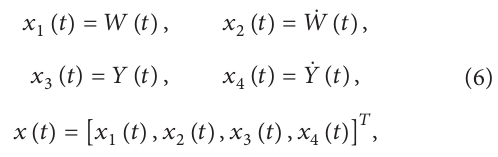
in which 𝑊(𝑡) is cable displacement from the equilibrium position; 𝑌(𝑡) is the displacement of the cable end, namely, the deck displacement along the axial direction of the cable; 𝜔 𝑢(𝑡) is control input variable; 𝜔 1 and 2 are the intrinsic frequencies of the cable and deck, respectively; 𝜉 is the damping ratio of the deck; 𝑎 𝑖 (𝑖 = 1, 2, . . . , 6) are parameters determined by the factors such as the mass per unit length and the dip angle of the cable and the regular function of the deck vibration